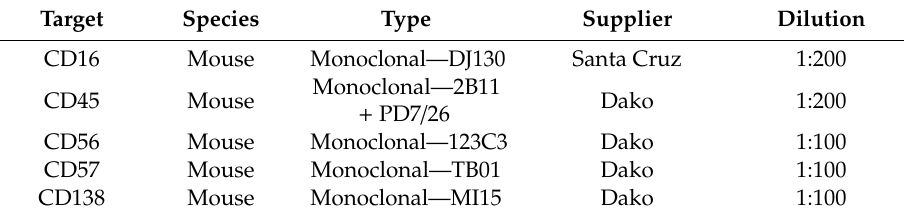
Table 1. List of antibodies used in the immunohistochemical